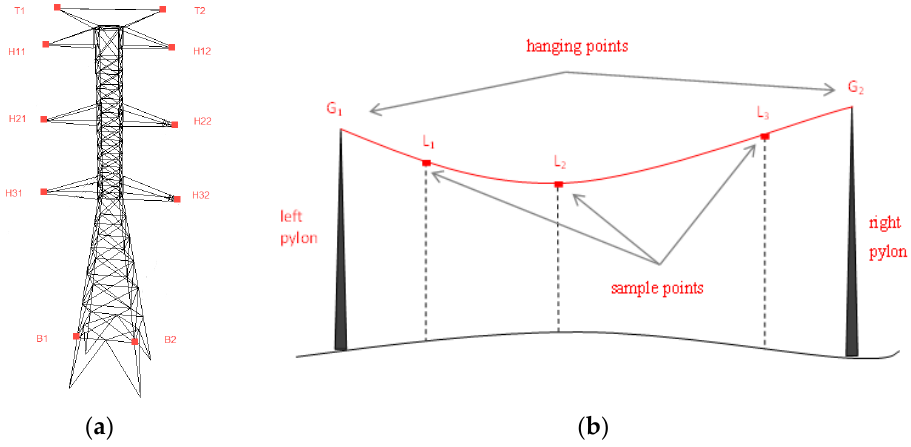
Figure 7. Model key points survey: ( a ) key points of power pylon; and ( b ) key points of power line.